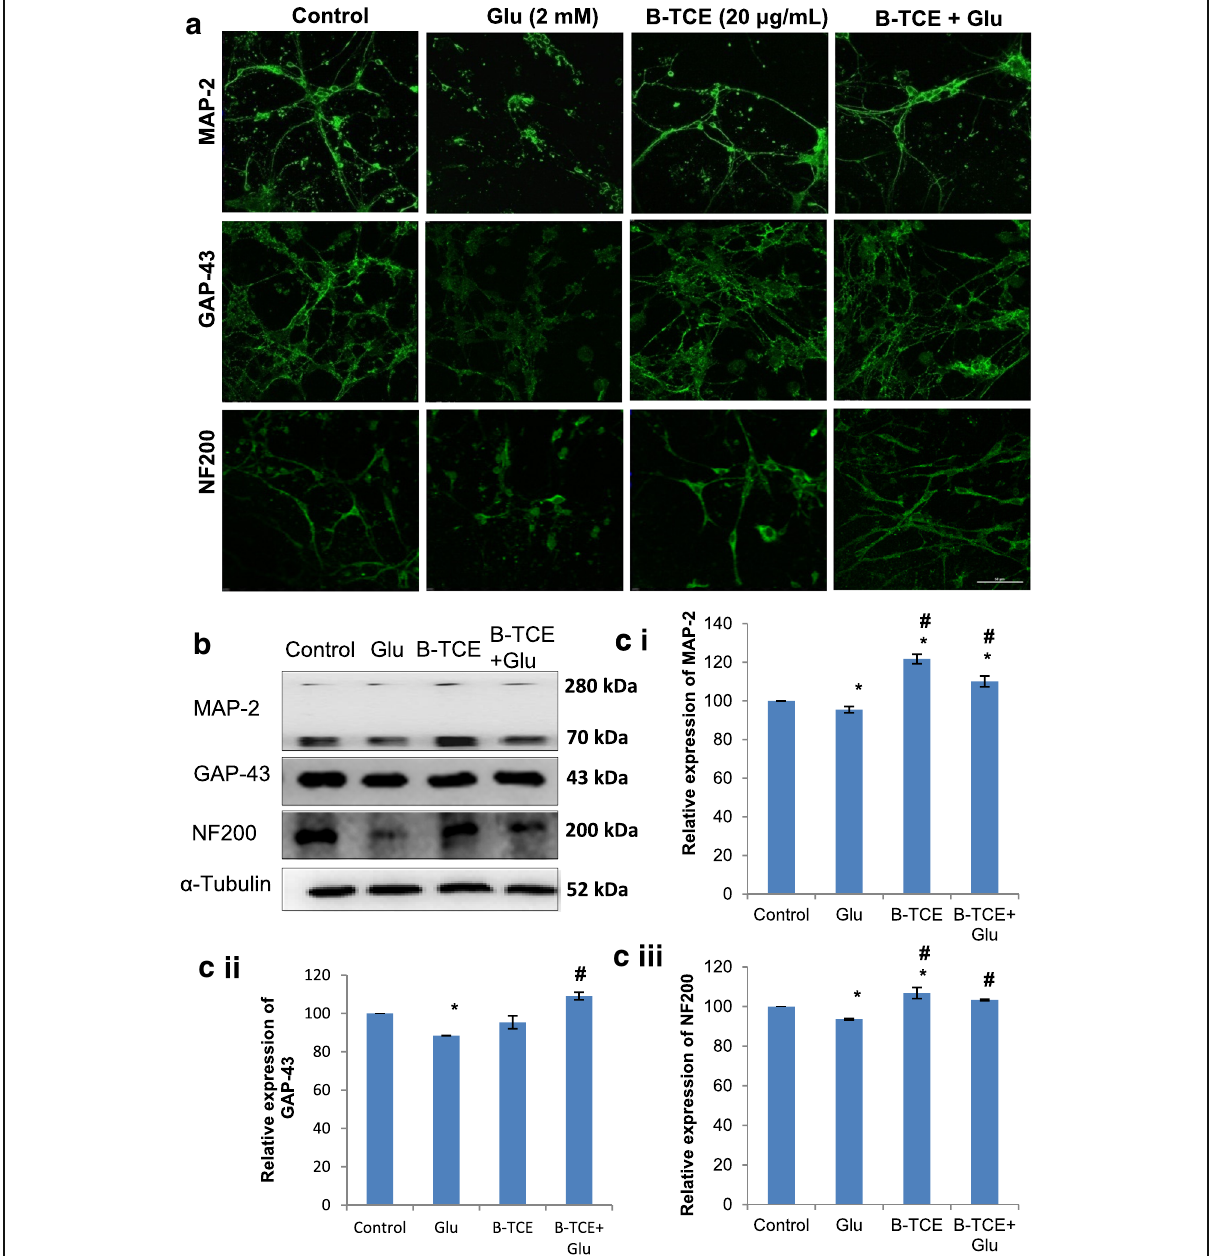
Fig. 2 B-TCE pretreatment suppressed the neuronal degeneration induced by glutamate by modulating the expression of neuronal structural markers. a ) Confocal micrographs of Control, Glutamate (2 mM), B-TCE (20 μ g/mL) and B-TCE + Glu treated primary cerebellar neurons immunostained for MAP-2, GAP-43 and NF200. b ) Representative immunoblots for MAP-2, GAP-43 and NF200 where α -Tubulin was used as internal control. c ) Histogram representing relative expression of MAP-2 (i), GAP-43 (ii) and NF200 (iii) obtained from normalized relative optical densities of bands. Data was compared between Control and other groups such as Glutamate, B-TCE and B-TCE + Glu ( * p ≤ 0.01) as well as Glutamate alone with B-TCE and B-TCE + Glu groups ( # p ≤ 0.01). Confocal Images were captured at 60X objective (Scale bar: 50 μ B-TCE normalized glutamate-induced enhanced expression of stress chaperone proteins To investigate the effect of glutamate on stress chaperone proteins expression and whether B-TCE